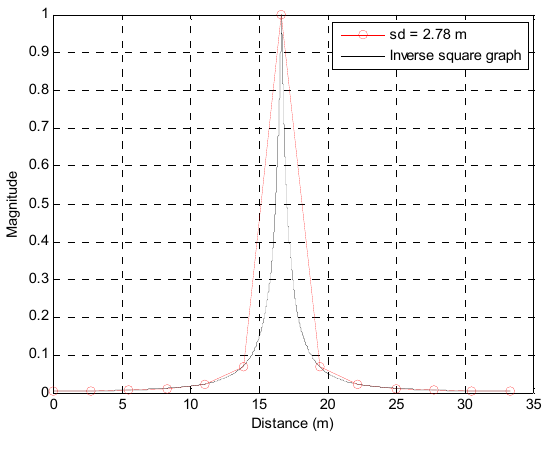
Figure 6. Example of sampling distance (target velocity = 10 km/h and sampling frequency = 1